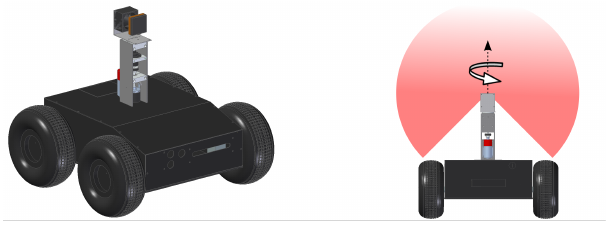
Figure 6: Laser turret of